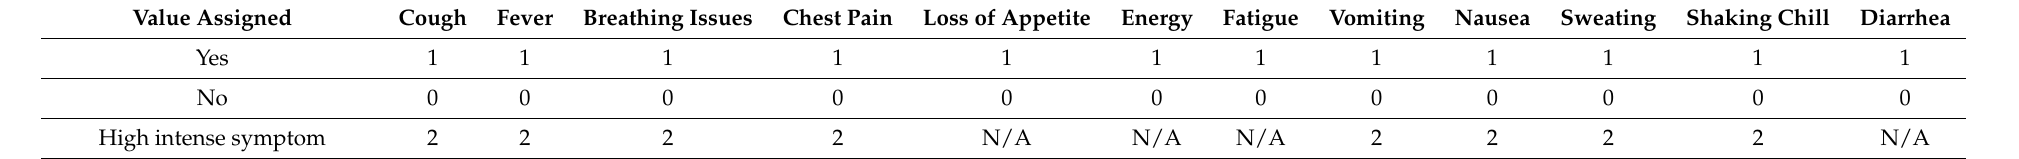
Table 2. Representation of dataset.